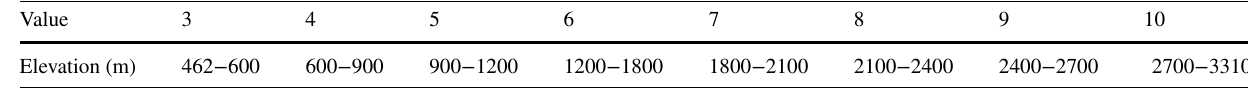
Table 1 The altitude variable and scoring